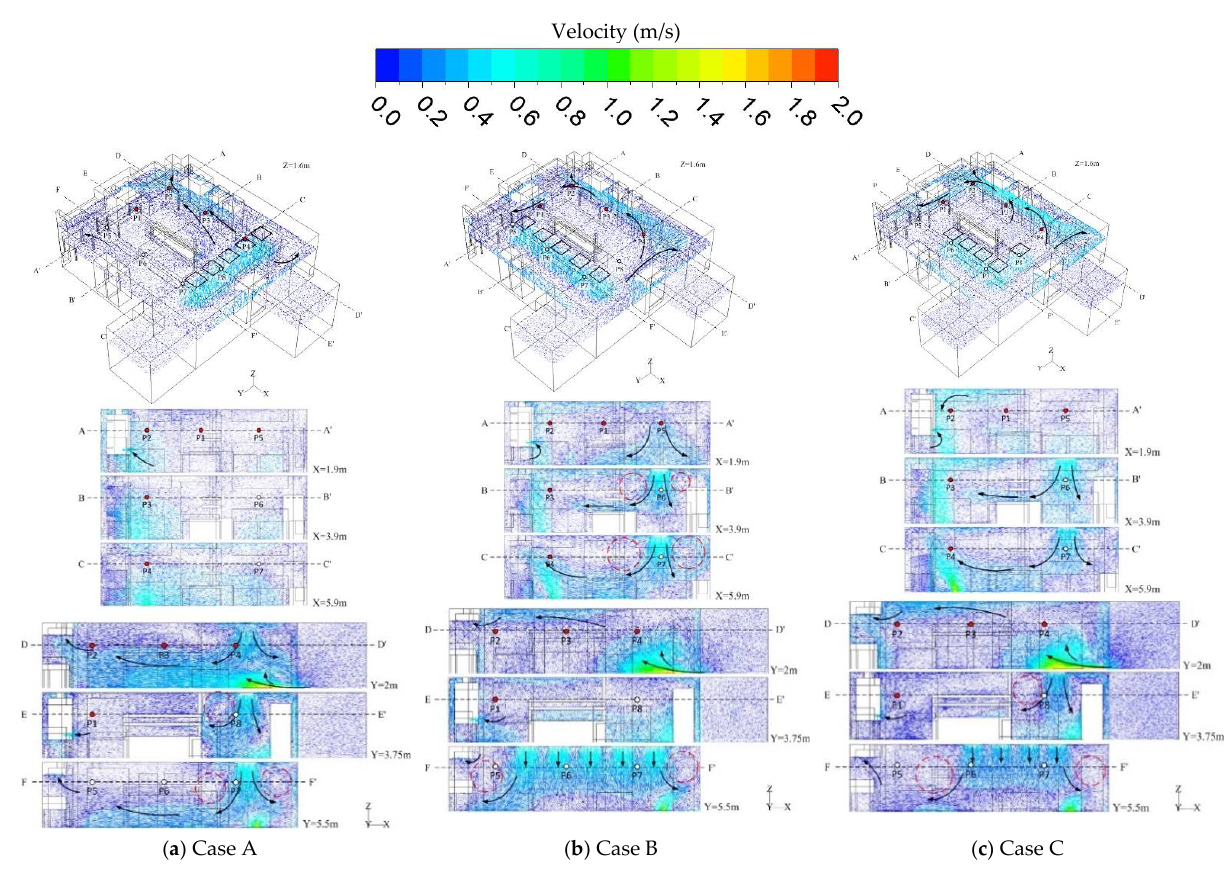
Figure 10. Airflow distribution results in different layout arrangements.